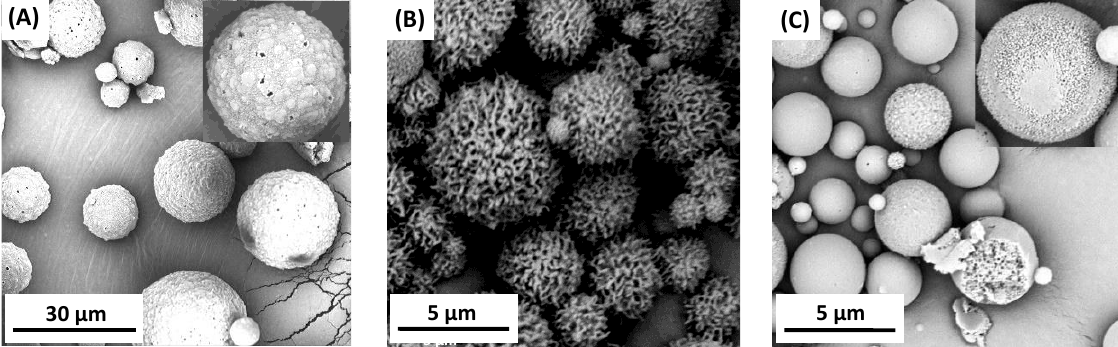
Figure 7. SEM images of polyDBB_PEG_600_20 microspheres obtained by using homogenization speed of 3000 rpm ( A ), 18,000 rpm ( B ) and 9000 rpm ( C ).